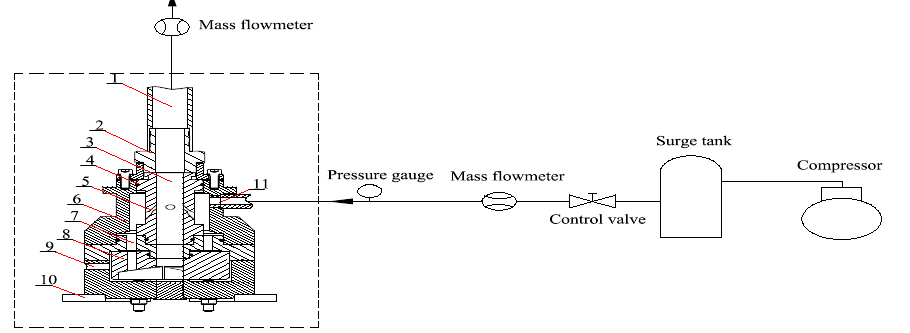
Figure 2. Reverse-circulation drilling apparatus based on supersonic nozzle. 1. Air outlet; 2. Top joint; 3. Center passage; 4. Seal ring; 5. Supersonic nozzle; 6. Outer shell; 7.Flushing nozzle; 8. Bit crown; 9. Air vent; 10. Work bench; 11. Air inlete. Table 1. Factors and levels for L 27 (3 13 ) orthogonal